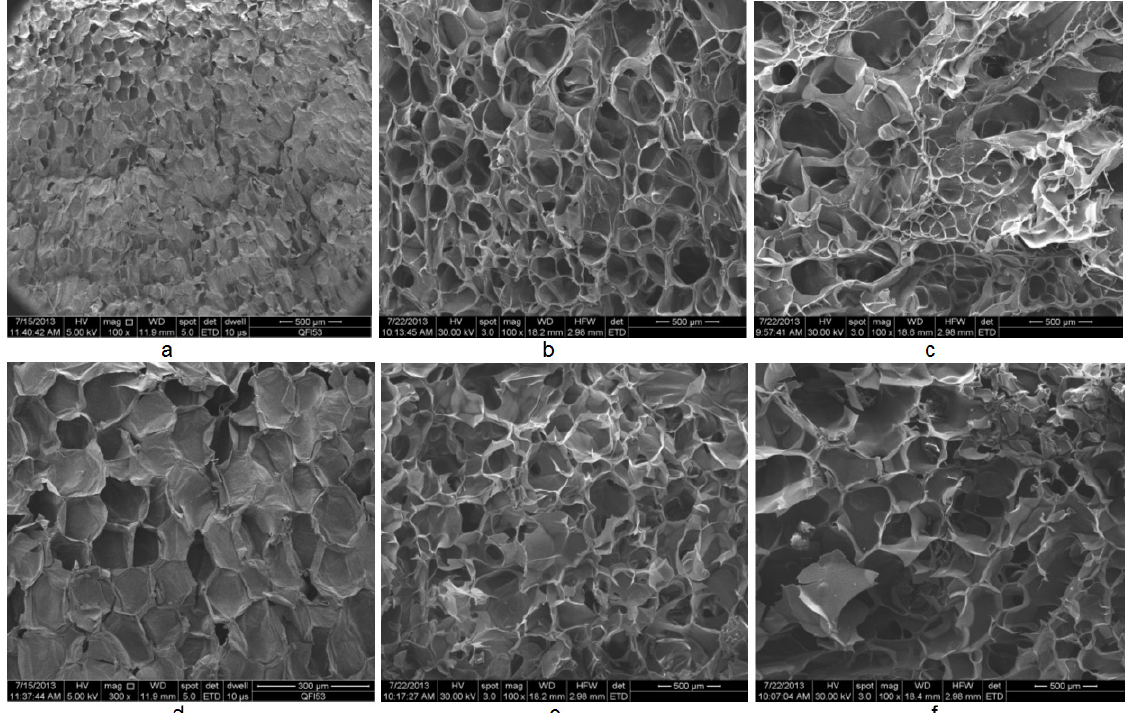
Figure 3. SEM images of fresh support: a) MSS surface; b) HEMA-PAAm surface; c) PAAm surface; d) MSS cross-section; e) HEMA-PAAm cross- section; f) PAAm